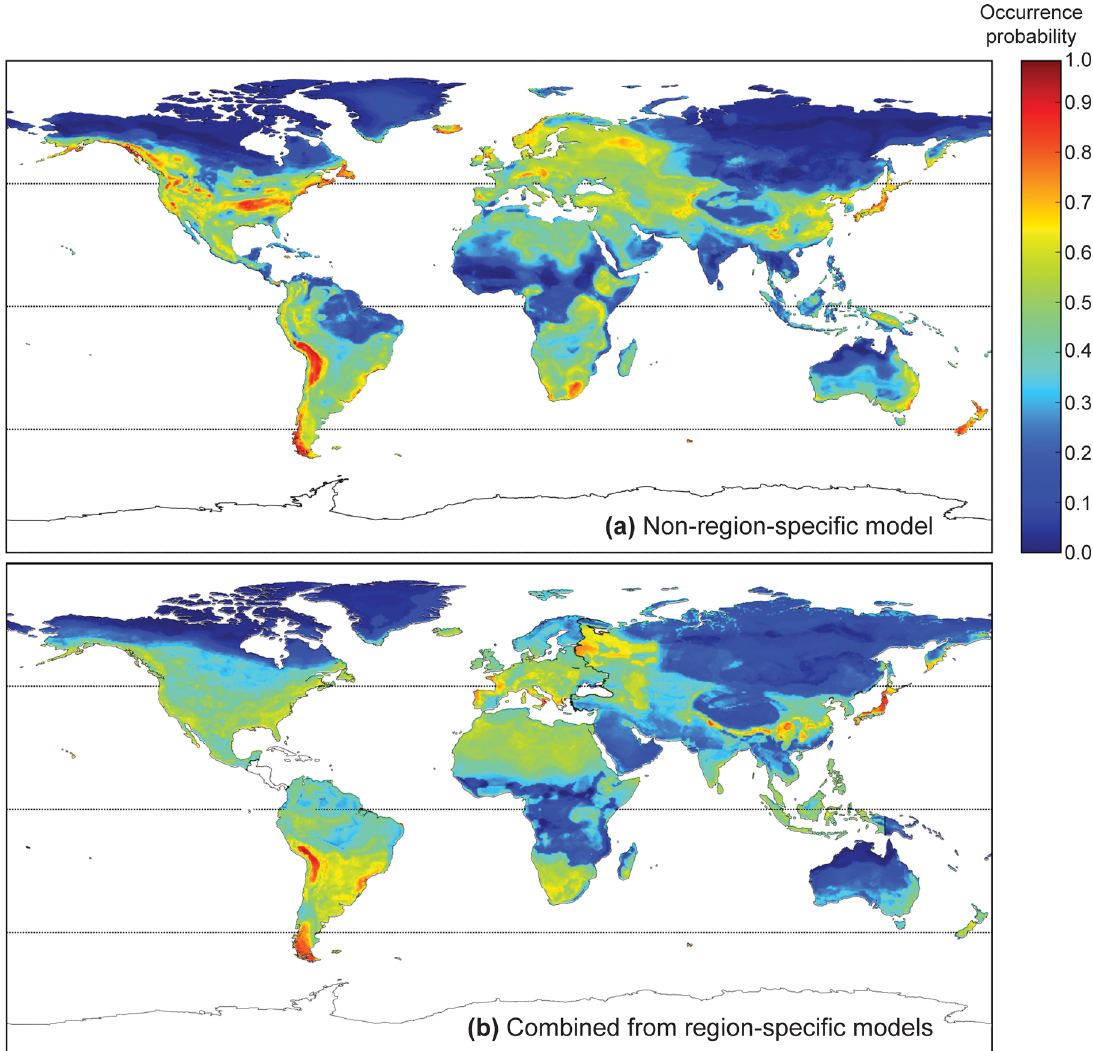
Fig 4. Predicted occurrence probability of amphibian chytrid fungus ( Batrachochytrium dendrobatidis ) with current climatic conditions. Predicted current occurrence of Batrachochytrium dendrobatidis based on: a) a non-region-specific global model; and b) data combined from region-specific